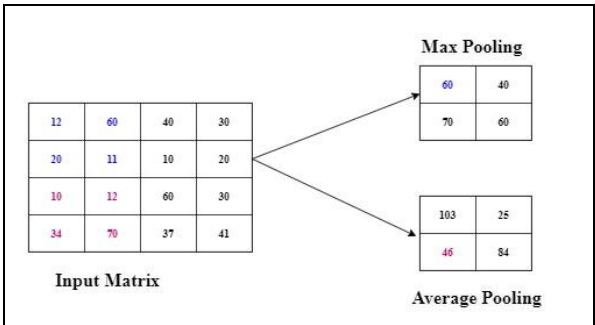
Figure 5. Max pooling. Figure 5. Max